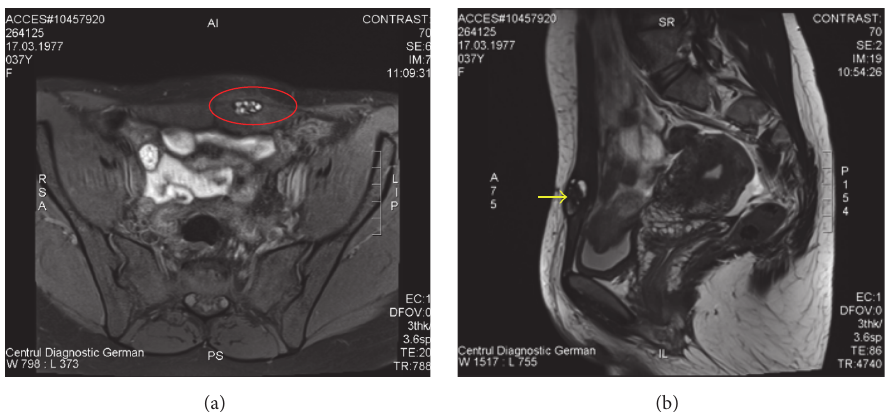
Figure 1: MRI: 21 × 23 × 28 mm heterogeneous mass in the lower left rectus abdominis muscle with focal areas of high and low signal